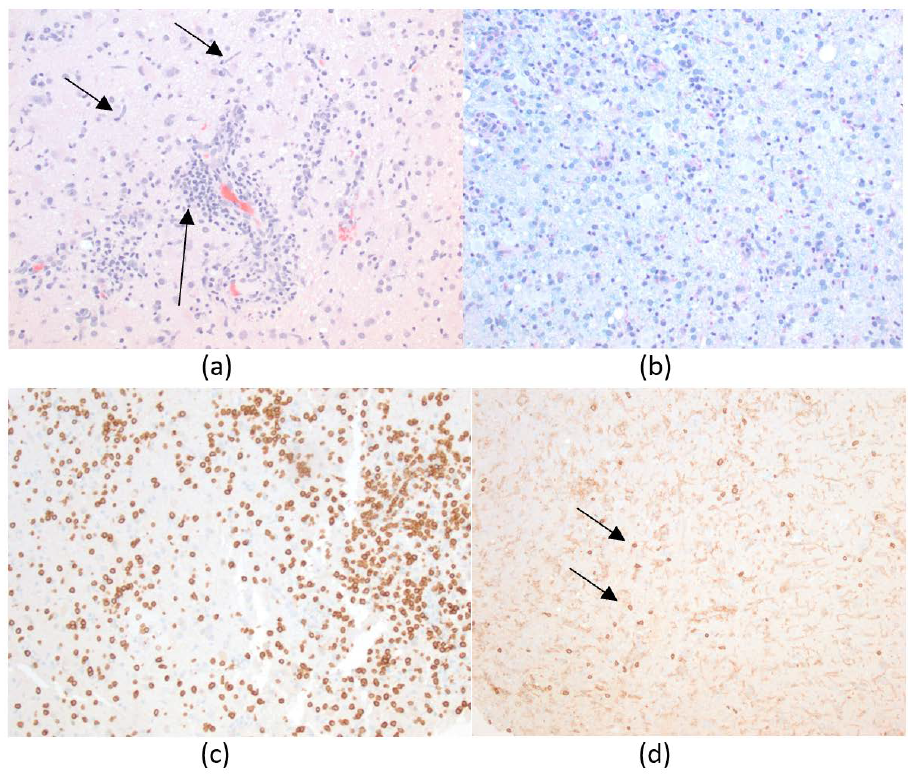
Figure 2. Histopathology: ( a ) An infiltrate of small, round lymphocytes is seen mainly around blood vessels (long arrow), and also scattered within the parenchyma on H&E stain. Prominent microglial proliferation (short arrows) is also present; ( b ) Essentially complete loss of myelin with no blue staining is seen on LFB/PAS stain; ( c ) Lymphocytic population is overwhelmingly comprised of CD8-positive T-cells on immunohistochemical staining; ( d ) CD4 highlights only an occasional CD4- positive T-cell (arrows) with a faint staining of microglial population in the background immuno- histochemical staining. 2. Discussion HIV is associated with a multitude of opportunistic infections of the CNS such as cryptococcus, tuberculosis, toxoplasma, CMV, EBV, JC virus etc., the majority of which are associated with a low CD4 count—typically less than 250 CD4 cells/μL [1–4]. They are less common in patients with a CD4 count greater than 500 cells/μL [5]. With the advent of highly effective ART, the overall incidence of HIV related opportunistic infections has decreased markedly over the last few decades [4,6]. Although mucocutaneous lesions with HSV are very common in patients with AIDS [4,5], HSV encephalitis in AIDS is not very common and both are usually seen in patients with a low CD4 count [5,7]. Our pa- tient had well-controlled HIV but still developed HSV encephalitis. His first presentation was typical for viral encephalitis and was treated early antiviral therapy. Untreated HSV encephalitis has a mortality rate as high as 70–90% [8]. Hence, early diagnosis and prompt treatment of encephalitis is important to prevent long-term sequelae for the patient and to preserve life [4,9,10]. He had completed the course of antiviral therapy and clinically improved during the course of hospital admission. He subsequently presented with worsening encephalopathy, seizures, and psycho- sis. At this presentation, diagnosis was not as straightforward and included incompletely